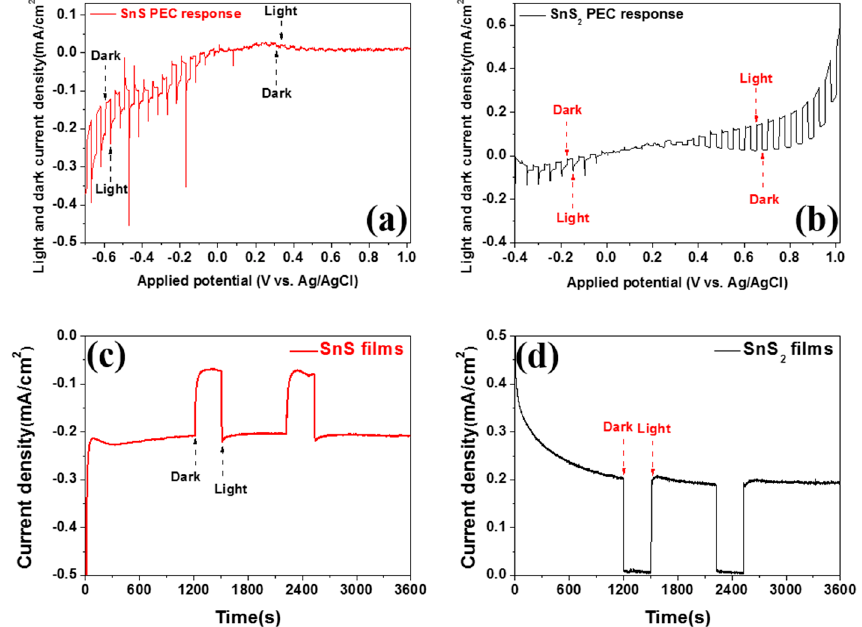
Figure 5. Linear sweep voltammetry plots for light on-off were recorded in 100 mW/cm 2 illumination and dark, respectively, at a scan rate of 5 mV/s for: ( a ) SnS thin film; and ( b ) SnS 2 thin film. Stability study of: ( c ) SnS thin film at − 0.6 V vs. Ag/AgCl; and ( d ) SnS 2 thin film at 0.8 V vs. Ag/AgCl for 3600 s.